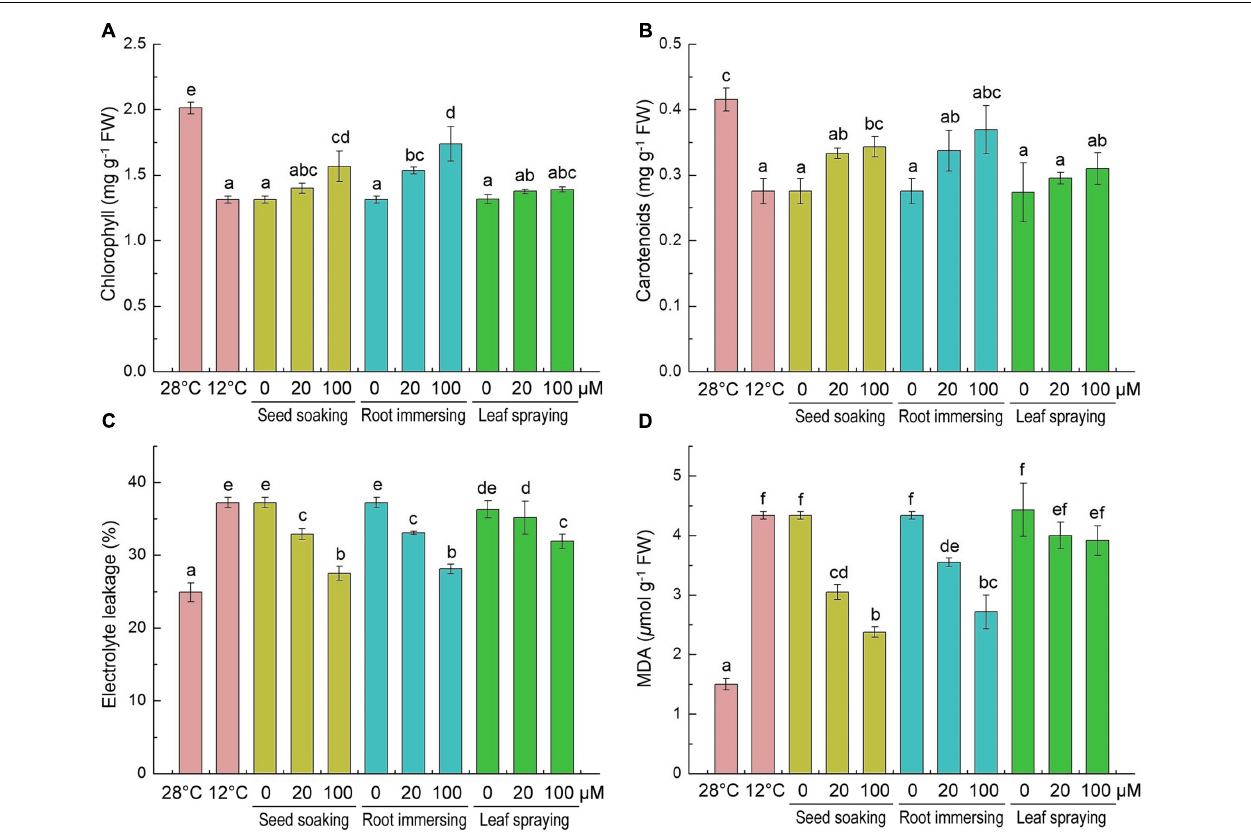
FIGURE 2 | Effects of exogenous melatonin on chlorophyll content (A) , carotenoids content (B) , electrolyte leakage (C) and malondialdehyde (D) after 6-day cold stress (12 ◦ C). Others are the same as in Figure 1